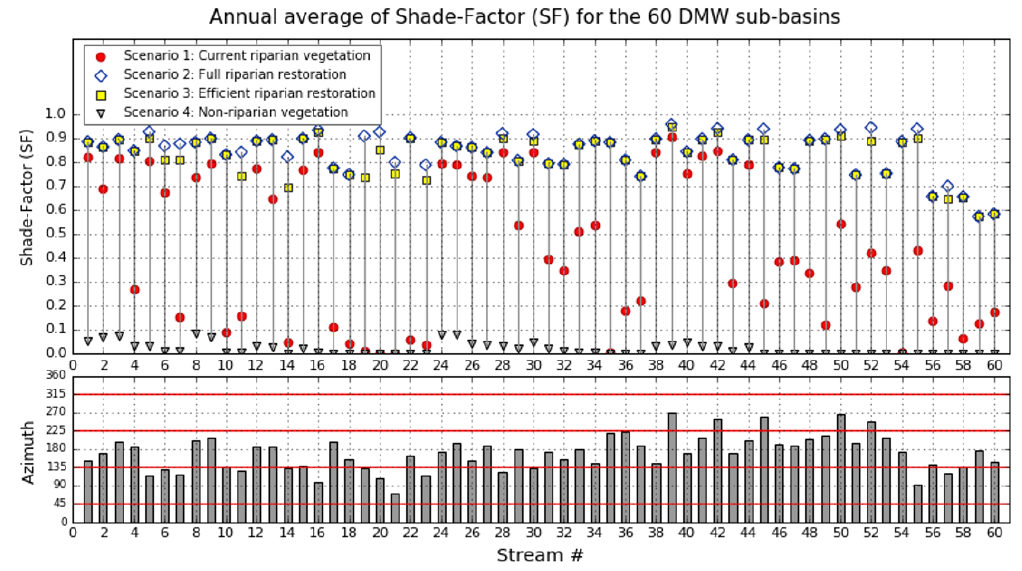
Figure 5. Annual average of shade factors (SFs) for the 60 DMW streams for scenarios 1, 2, 3, and 4.